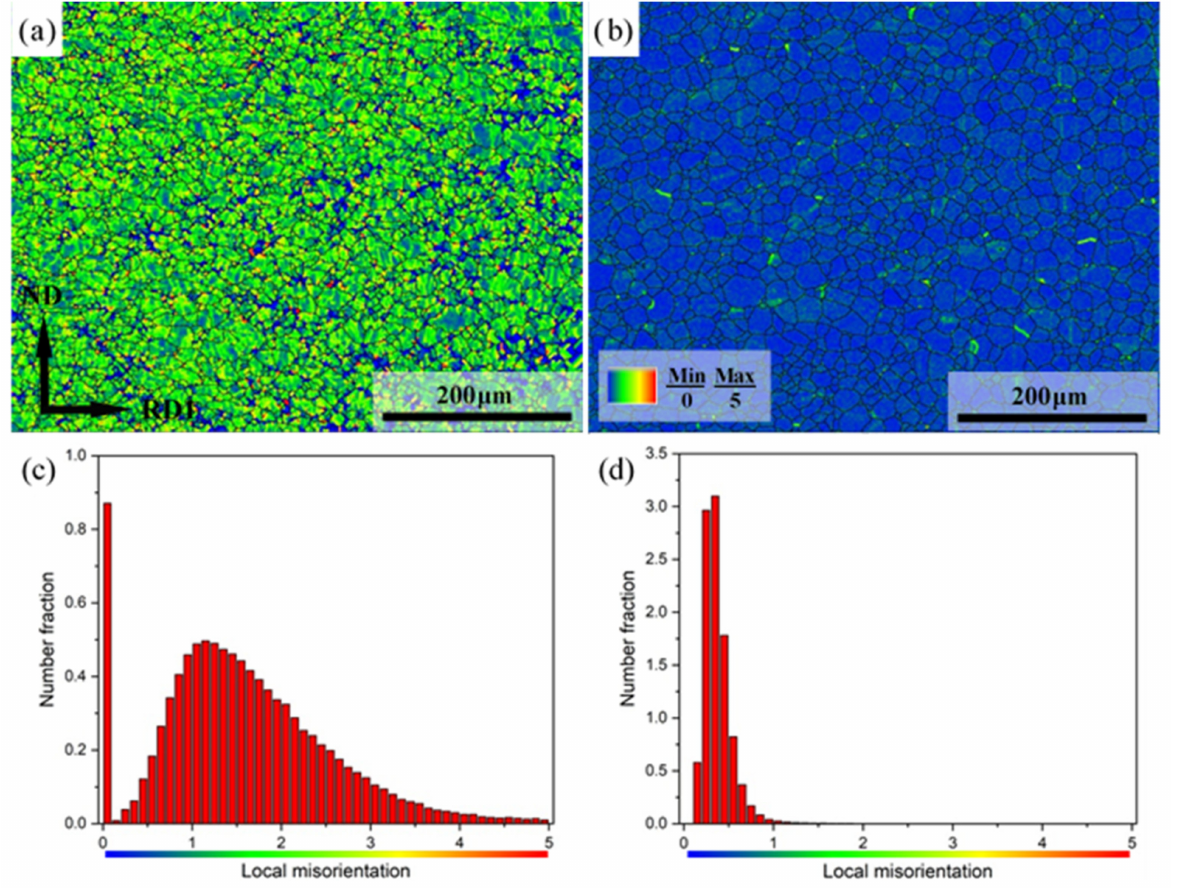
Figure 16. KAM maps of ( a ) as-rolled, ( b ) as-annealed, and corresponding local misorientation distributions of ( c ) as-rolled and ( d ) as-annealed Mg-3Y